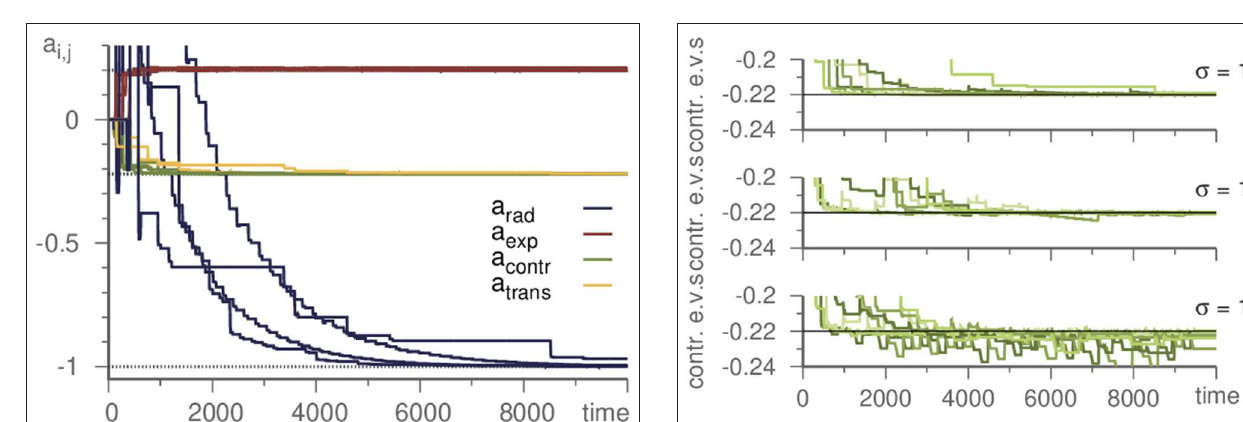
10 − 6 . For stronger noise in the = 5, γ 1, and = =